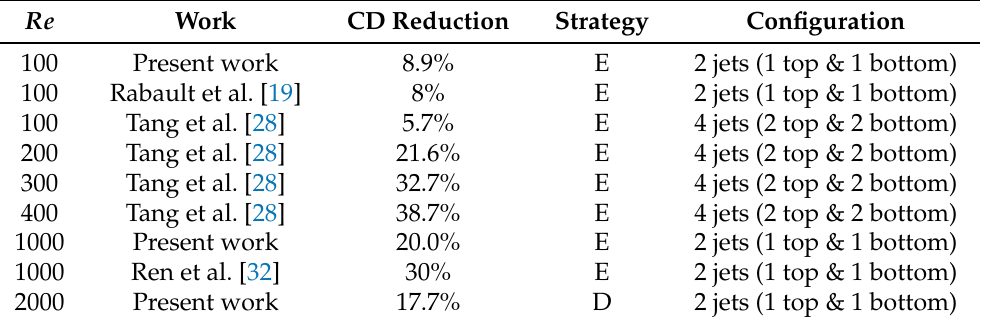
Table 2. Summary of the results and strategies. In the strategy, column E states the elongation of the bubble of recirculation and D states the delay of the detachment point through a high-frequency actuation. Note that for the four cases of Tang et al. [28], a unique agent is trained through transfer learning for all four Reynolds numbers and jets have small x -velocity